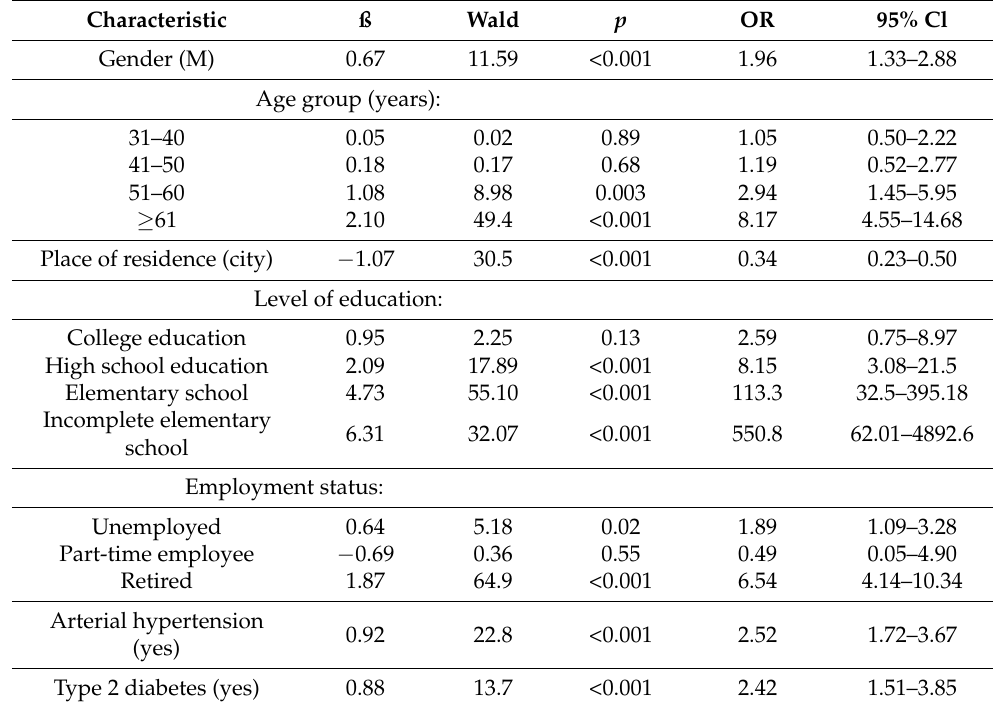
Table 6. Predicting the probability of an inadequate levels of health literacy (bivariate regres- sion